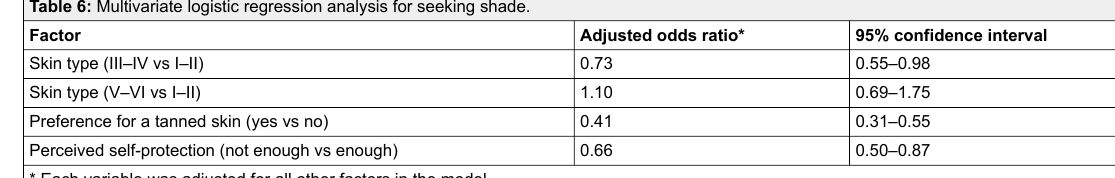
Table 6: Multivariate logistic regression analysis for seeking